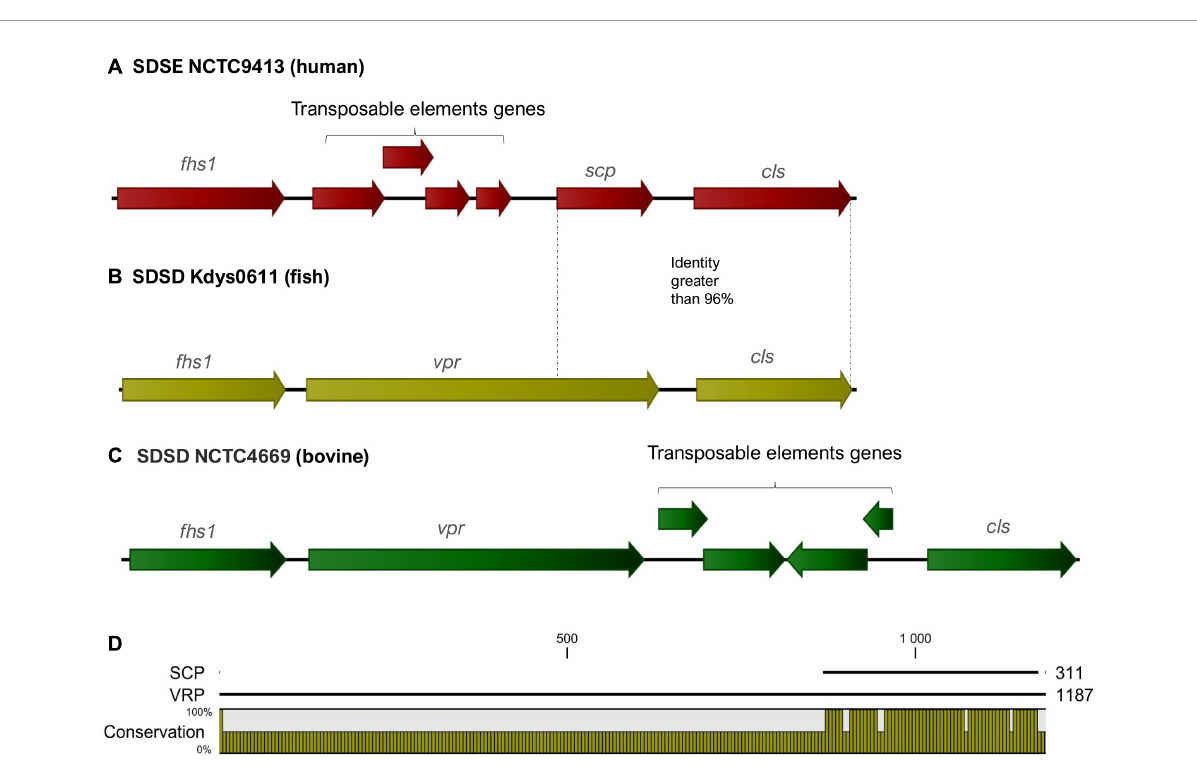
FIGURE6 (A–C) Graphical representation of the organization of the region flanking the gene that codes for the C5a peptidase. The fhs1 and cls genes encoding formate–tetrahydrofolate ligase and cardiolipin synthetase, respectively, shared an identity greater than 95% among S. dysgalactiae strains. The gene identified as vpr (C5a peptidase precursor ScpZ) in strain SDSENCTC4669 (CDS: VDZ40442.1) is shared among SDSD animals SDSE strains, while scp gene (C5a peptidase) of the SDSENCTC9413 strain (CDS: VTT04007.1) is shared among human SDSE strains. (D) BLASTp alignment of predicted proteins VPR and SCP suggests that scp is a fragment of the vpr gene and reveals that the region coding for the C5a peptidase is absent from the scp